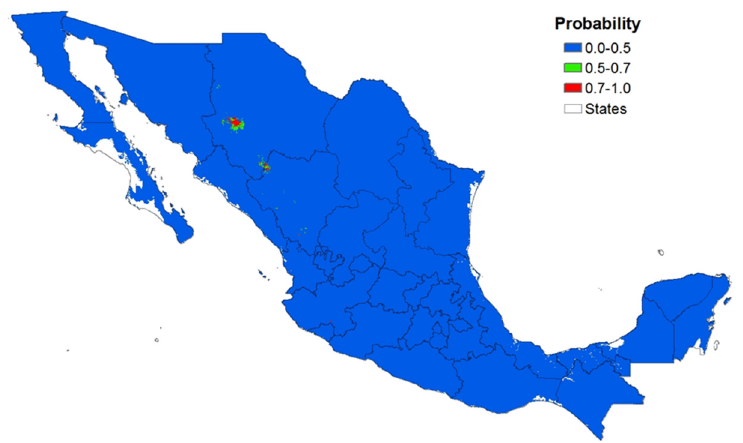
Figure 3. Map of the potential distribution of Picea chihuahuana Martínez in Mexico: model at national